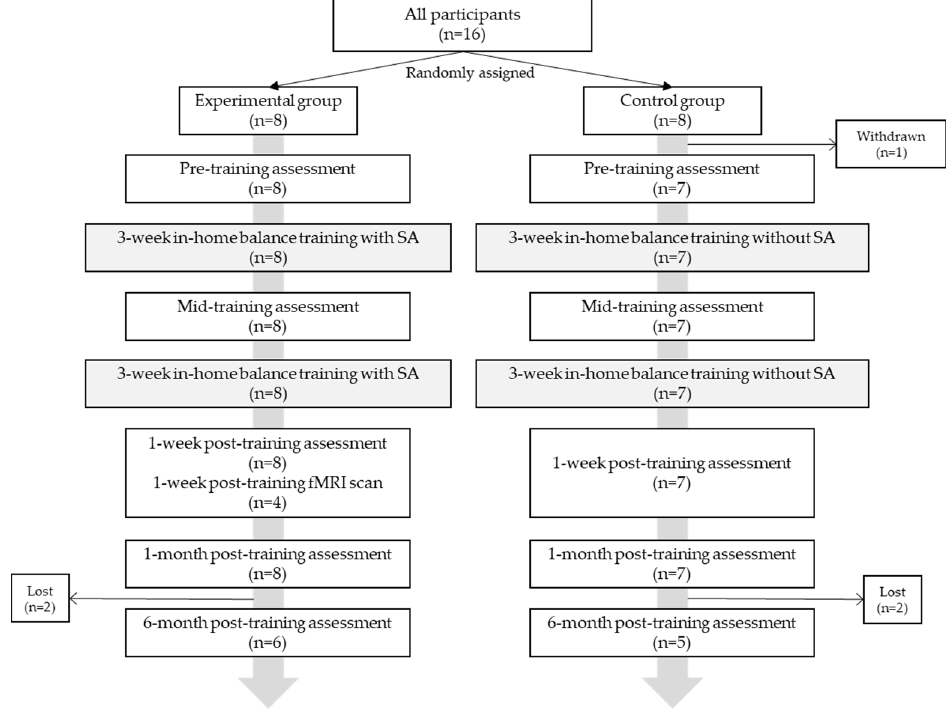
Figure 1. Participant allocation and experimental protocol.